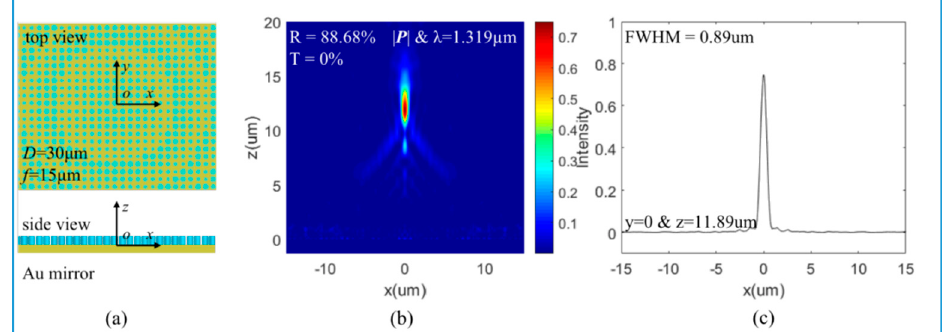
Figure 5. Focal features of meta-reflectors with Au film: ( a ) schematic of a meta-reflector with Au film as a bottom mirror, size D = 30 µm and focal distance f = 15 µm; ( b ) Focal profile of the reflected light on the x - z plane with y = 0; ( c ) FWHM of the focus spot at z = 11.89 µm.